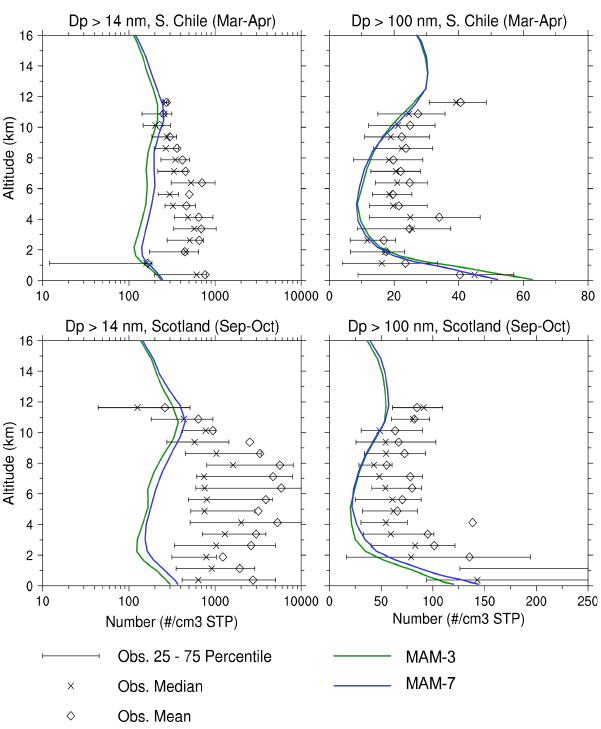
Fig. 22. Vertical profiles of aerosol number concentration of particles with diameter > 14 nm (left) and particles with diameter > 100 nm (right), near Punta Arenas, Chile during March/April (top) and near Prestwick, Scotland in September/October (bottom). Observations are from Minikin et al. (2003): median (star), 25 and 75 percentiles (left and right end of error bars). Model results for MAM3 and MAM7 are averaged over latitude-longitude ranges of 60–50 ◦ S, 70–85 ◦ W for Chile, and over 50–60 ◦ N, 10 ◦ W–5 ◦ E for Scotland.